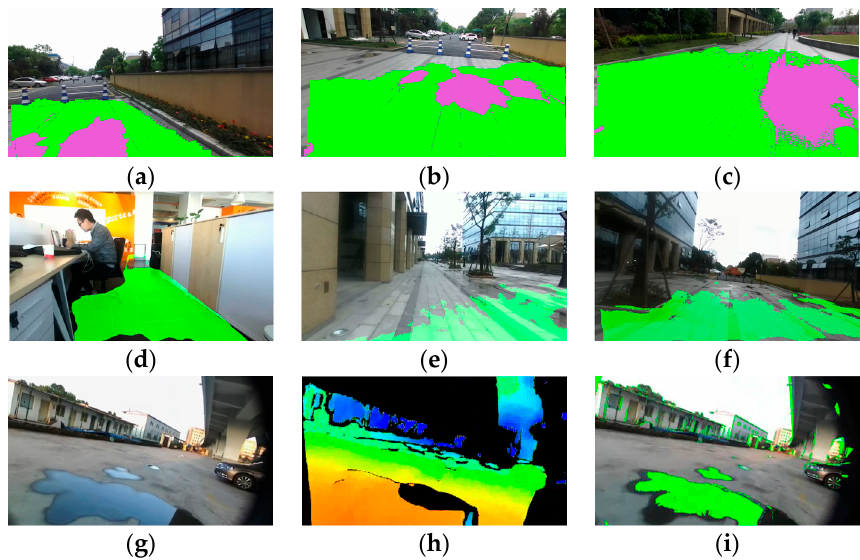
Figure 12. The detection results of different approaches. ( a – c ) Results of the proposed approach; ( d – f ) Results of traversable area detection based on RANSAC plus filtering techniques; ( g – i ) Results of water hazard detection based on sky light effect modelling.